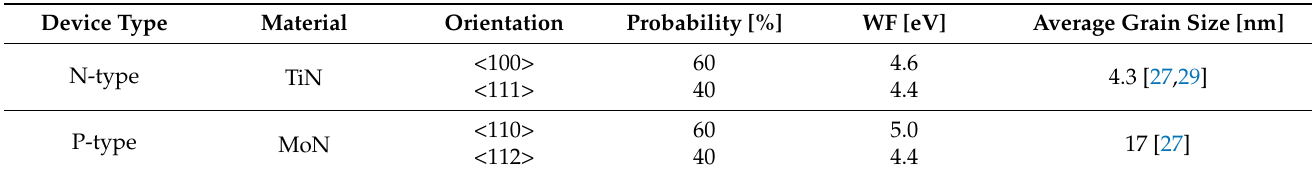
Figure 1. ( a ) Cross-section view of monolithic 3D-inverter (M3D-INV) and ( b ) work-function variation (WFV) of the metal grain on the gate of the top- or bottom-tier metal-oxide-semiconductor field effect transistors (MOSFETs). Here, monolithic inter-tier via (MIV) is shown. The dielectric material of inter-layer dielectric (ILD) is SiO 2 . Table 1. Physical properties of gate materials used for NMOSFET and PMOSFET (orientation, probability, work function, and average grain size).